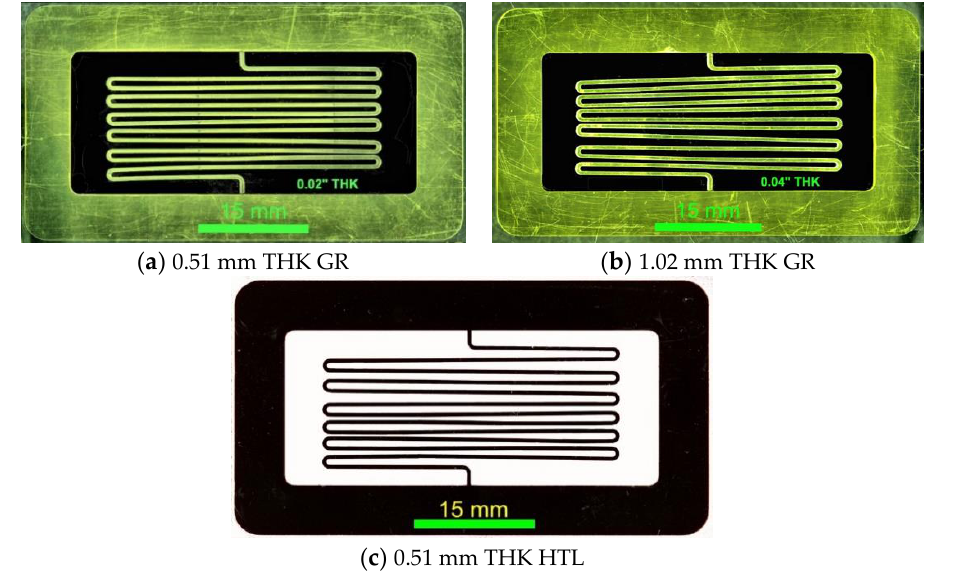
Figure 10. 3 D-printed flexures (BMF). Figure 10. 3D-printed flexures